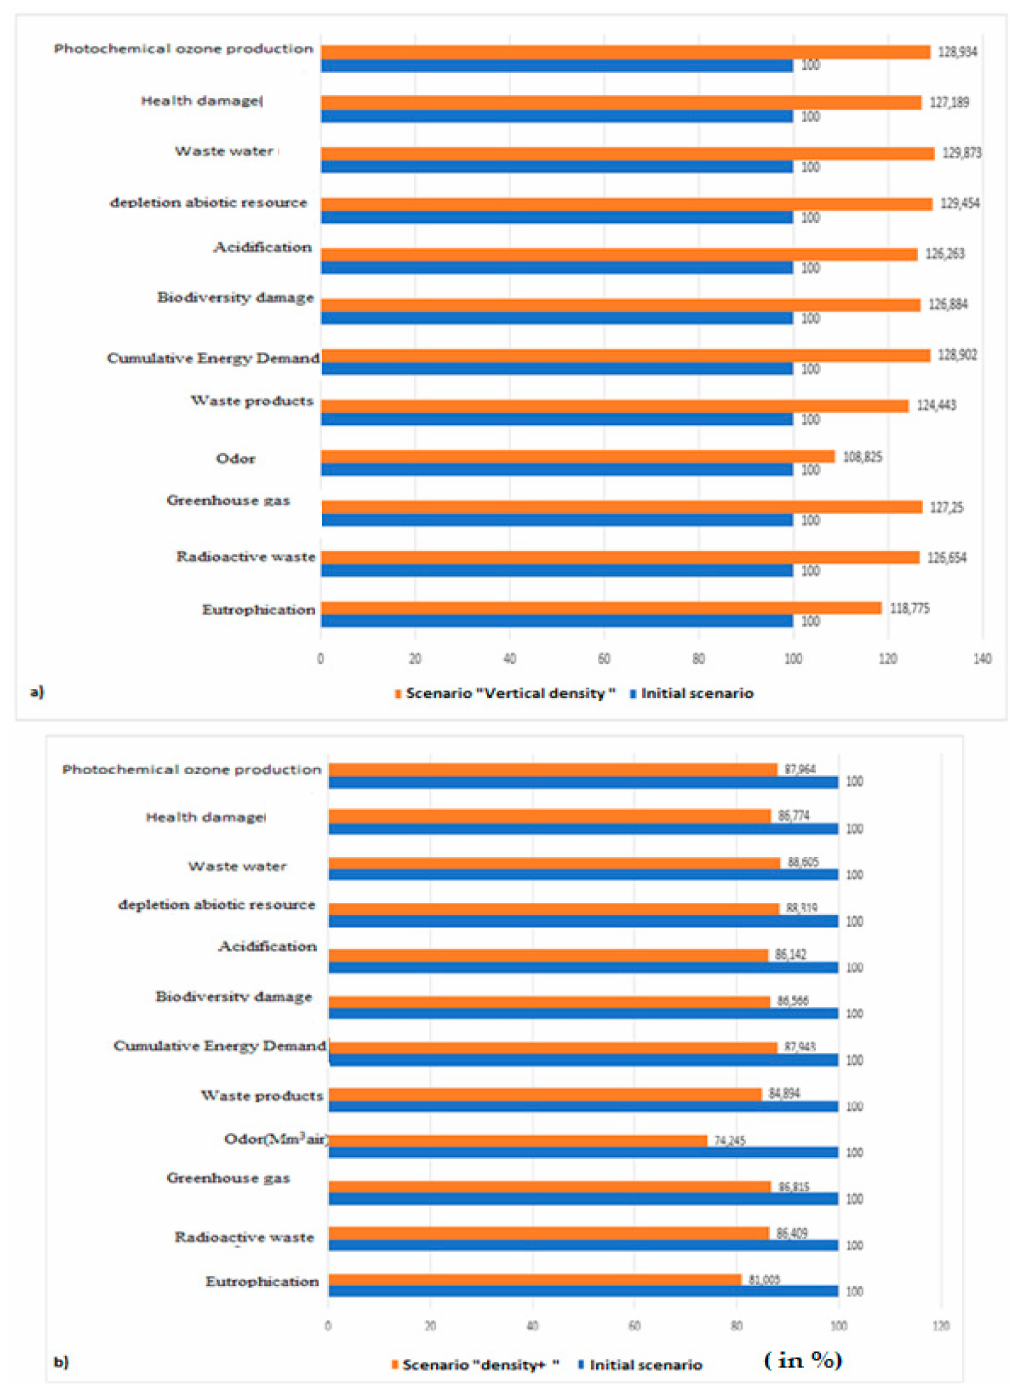
Figure 12. Comparative diagram of the environmental impacts of: ( a ) “Initial” and “Vertical Density” (functional unit: occupant); and ( b ) “Initial” and “Density + ” scenarios (functional unit: entire